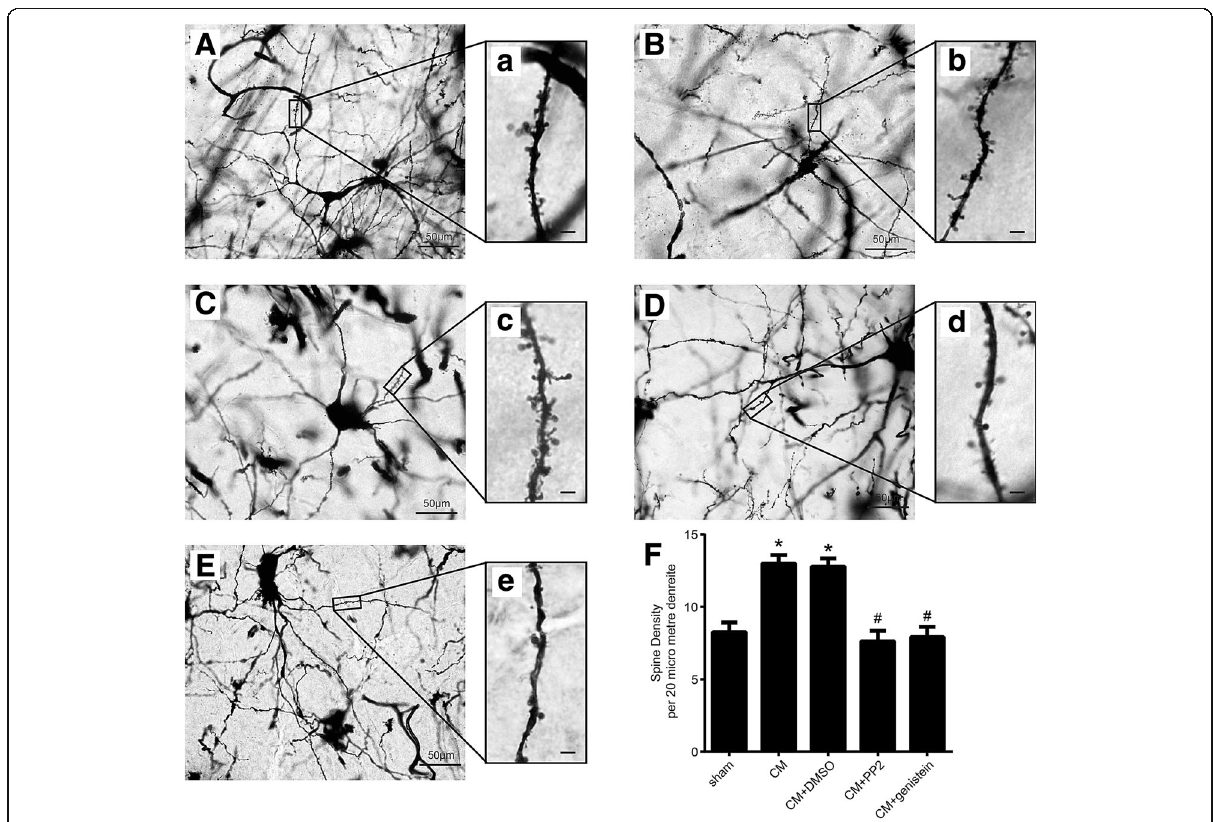
Fig. 8 Dendritic spine density of the TNC neurons in each group. a-e Low magnification of Golgi-Cox staining in the five groups ( a : sham group; b : CM group; c : CM + DMSO group; d : CM + PP2 group; e : CM + genistein group, scale bar = 50 μ m). a - e Enlarged images of neurons with dendrites that were used for the quantification of the spine density in the five groups; these images correspond to those shown in a - e ( a : sham group; b : CM group; c : CM + DMSO group; d : CM + PP2 group; e : CM + genistein group, scale bar = 4 μ m). f Golgi-Cox staining showed that the dendritic spine density was significantly higher in the CM group compared with that in the sham group, and there was no significant difference between the CM and CM + DMSO groups. PP2 and genistein significantly reduced the dendritic spine density, indicating that tyrosine- phosphorylated NR2B reduces the dendritic spine density in CM rats (n = 6 each group, * P < 0.05 compared with the sham group, # P < 0.05 compared with the CM + DMSO